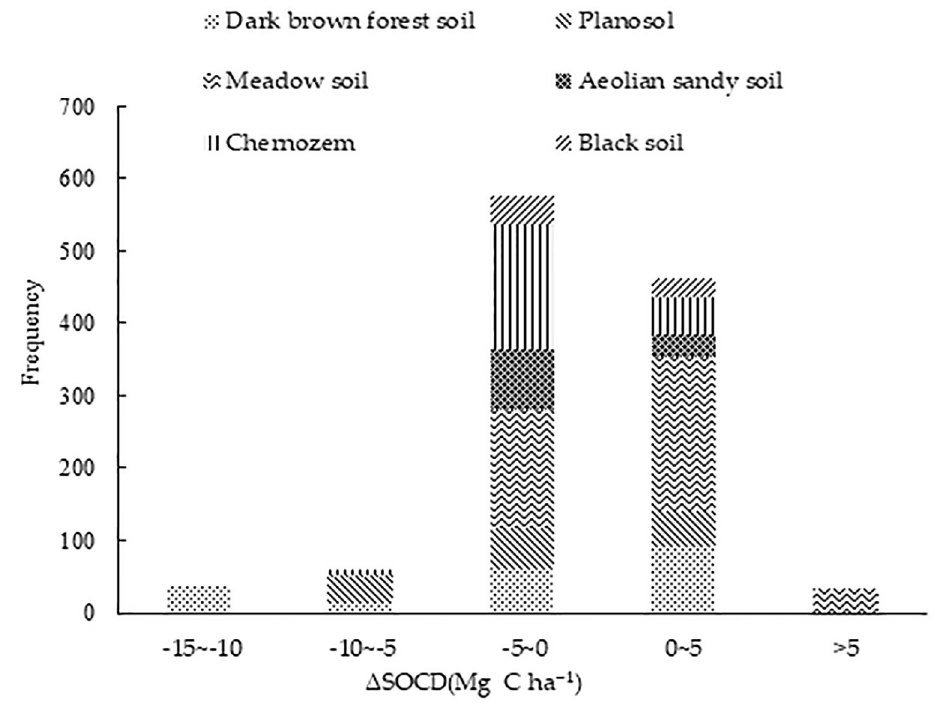
Fig 3. Frequency distribution of Δ SOCD in different soil groups in Jilin Province,